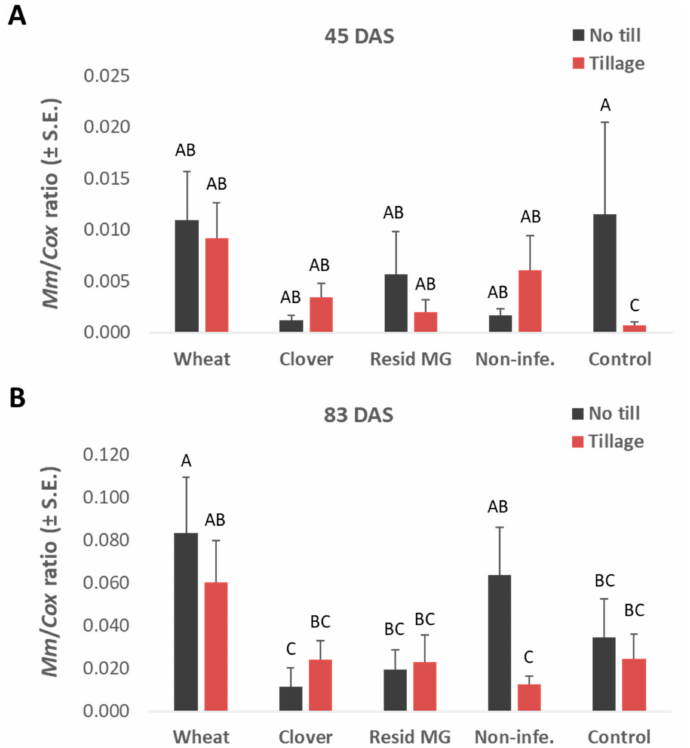
Figure 4. Greenhouse real-time PCR (qPCR) analysis measures of the pathogen DNA at 45 ( A ) and 83 ( B ) DAS in the plants’ roots and stems’ aboveground first internode, respectively. The